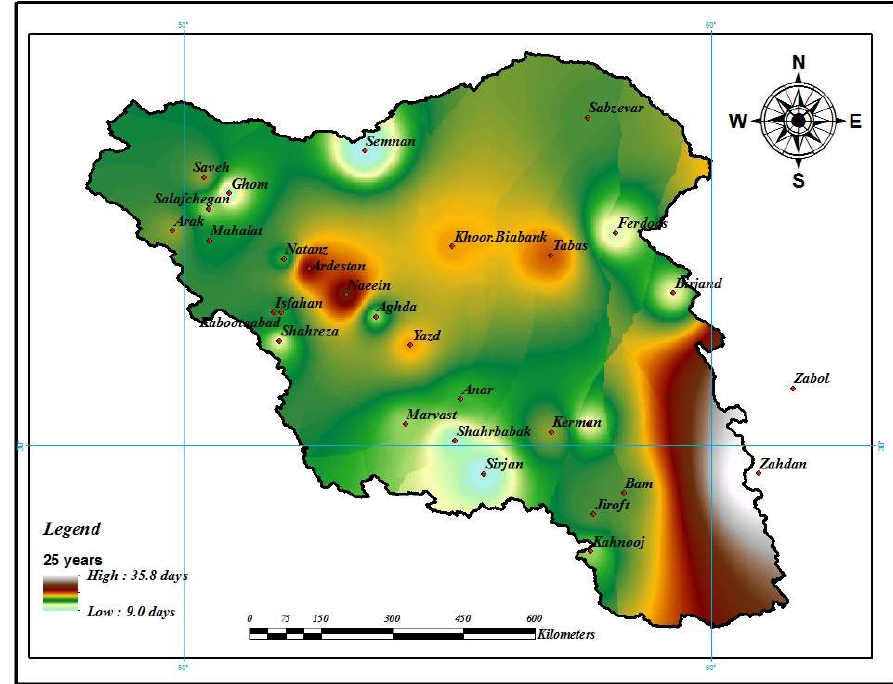
Figure 14. Dust day duration in the 25-year return period in the study area.